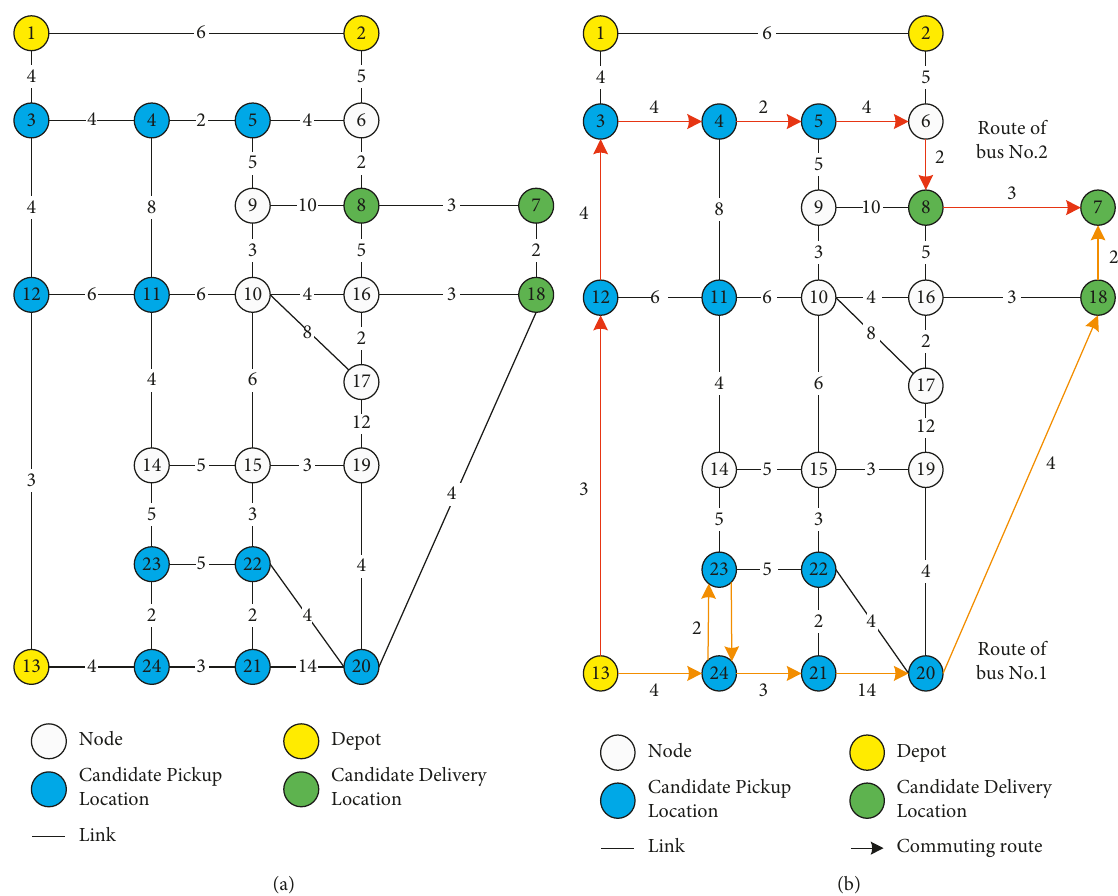
Figure 4: The simplifying Sioux Waterfall Network. (a) The basic information of the road network and customers. (b) The final solution and commuting routes. Table 4: Passenger trip requests on the simplifying Sioux Waterfall Network. Customers